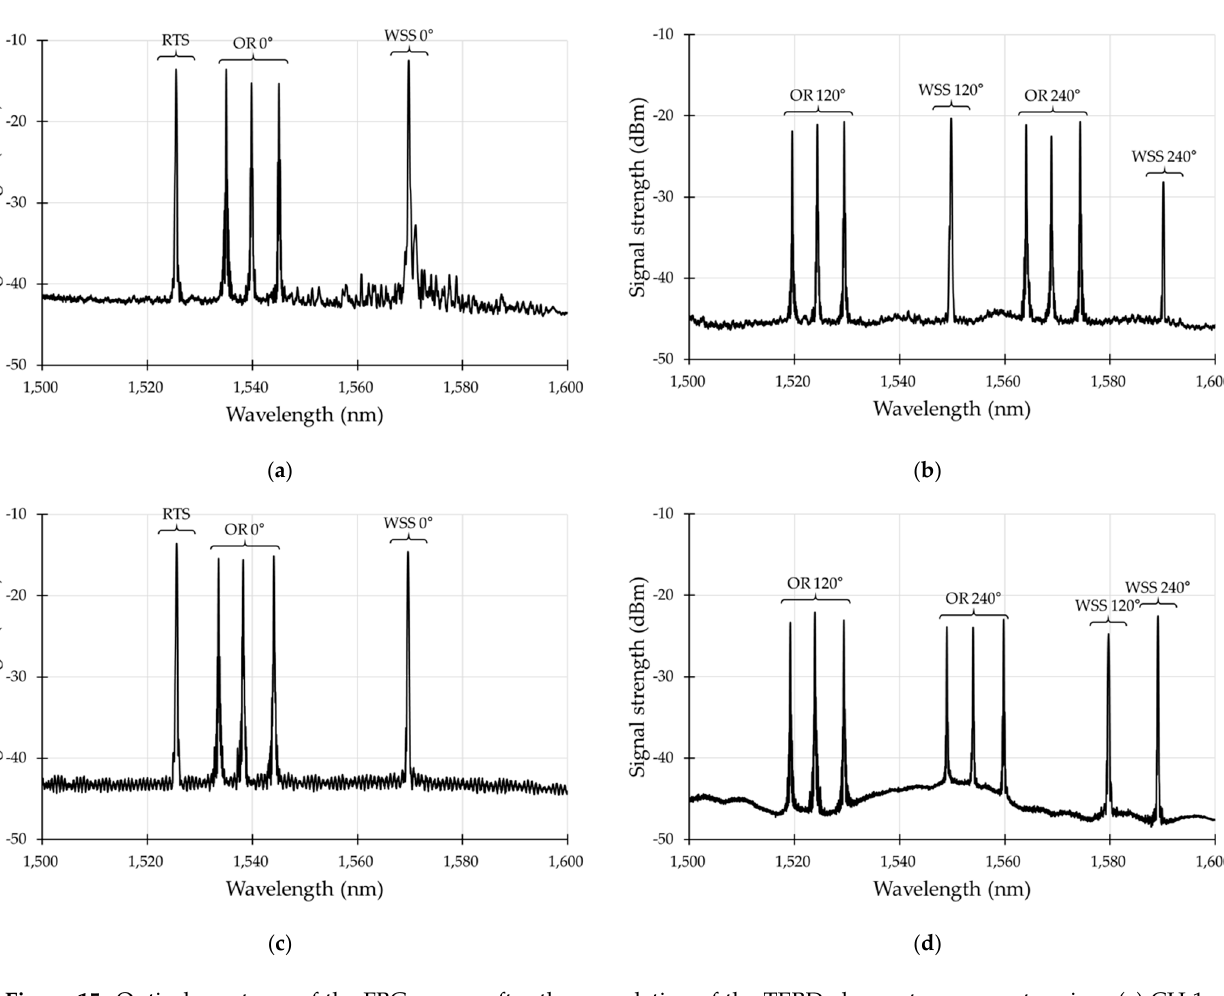
Figure 15. Optical spectrum of the FBG sensor after the completion of the TEBD observatory cement curing: ( a ) CH 1; ( b ) CH 2; ( c ) CH 3; ( d ) CH 4.